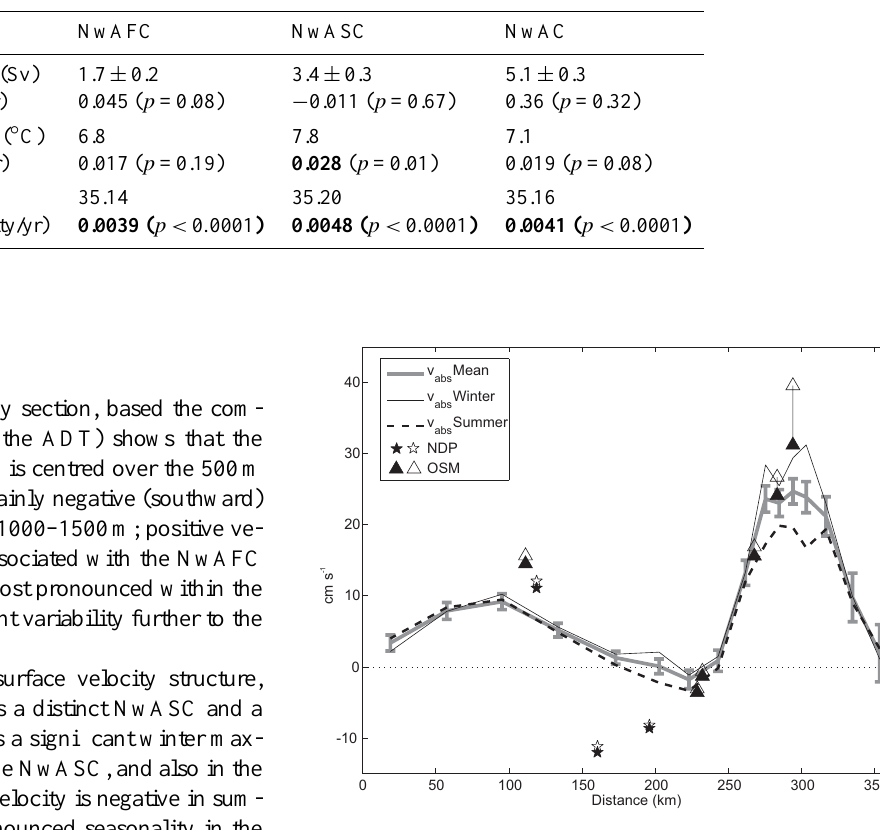
Fig. 3. Mean averaged surface velocity with standard error es- timates for annual mean, winter and summer from ADT data in the Svinøy section. Velocities from single CMs are from Orvik et al. (2001, ref OSM) while velocities from ADCPs are from Lønseth et al. (2003, ref NDP). Filled markers are the measurements at 100m depth while the non-filled markers are velocities at the sur- face where mean baroclinic shears, using hydrography, are added to the measurements at 100m